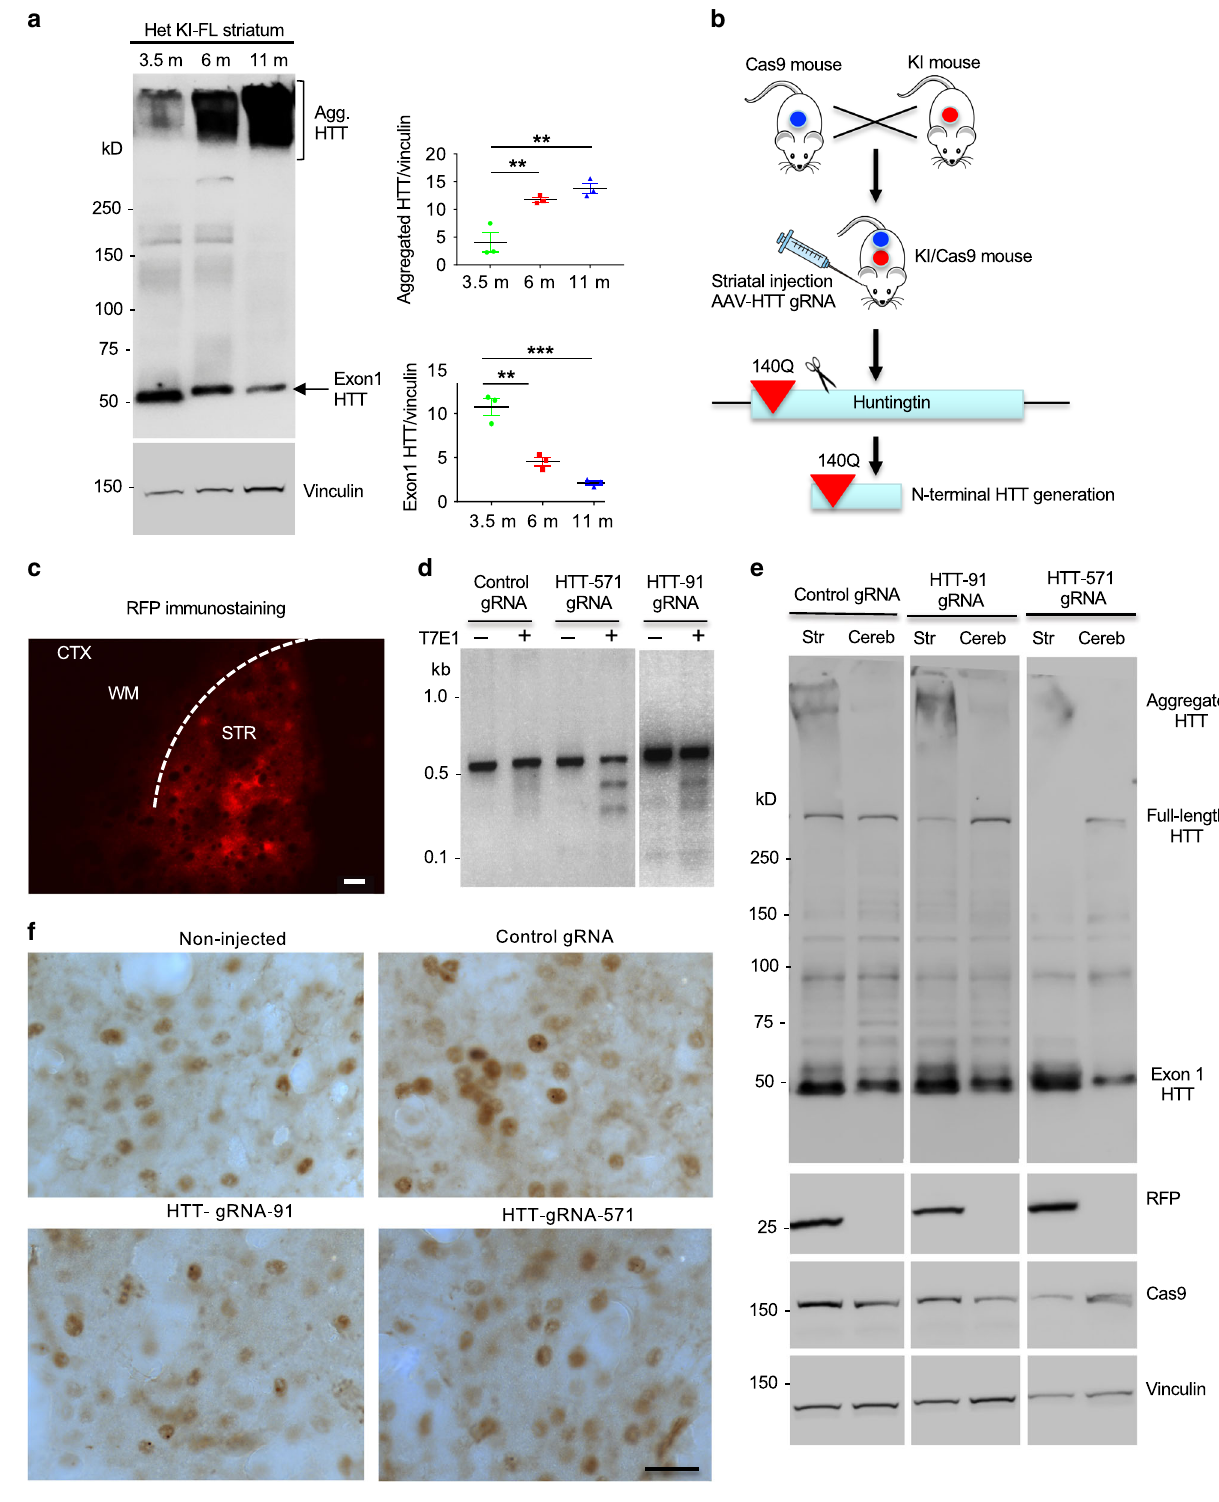
of mutant HTT. To this end, we used gRNA to target the endogenous mouse HspBP1 and veri fi ed that expression of HspBP1-gRNA via AAV could effectively reduce HspBP1 in cultured mouse striatal neuronal cells (Fig. 7c). We then performed stereotaxic injection of AAV HspBP1-gRNA and AAV control gRNA in the right and left striatum, respectively, of HD KI/Cas9 mice at age of 25 weeks (Fig. 7d) in order to rigorously compare nuclear mutant HTT staining in the same